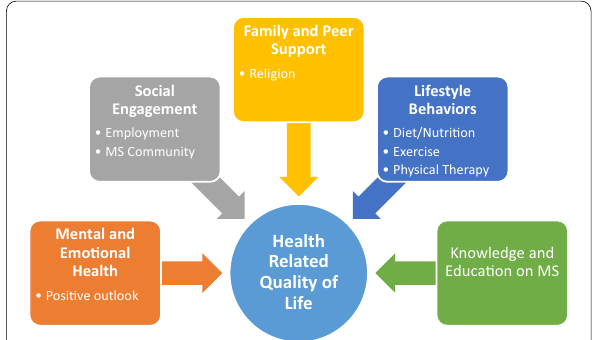
Fig. 1 Promotors of health related quality of life